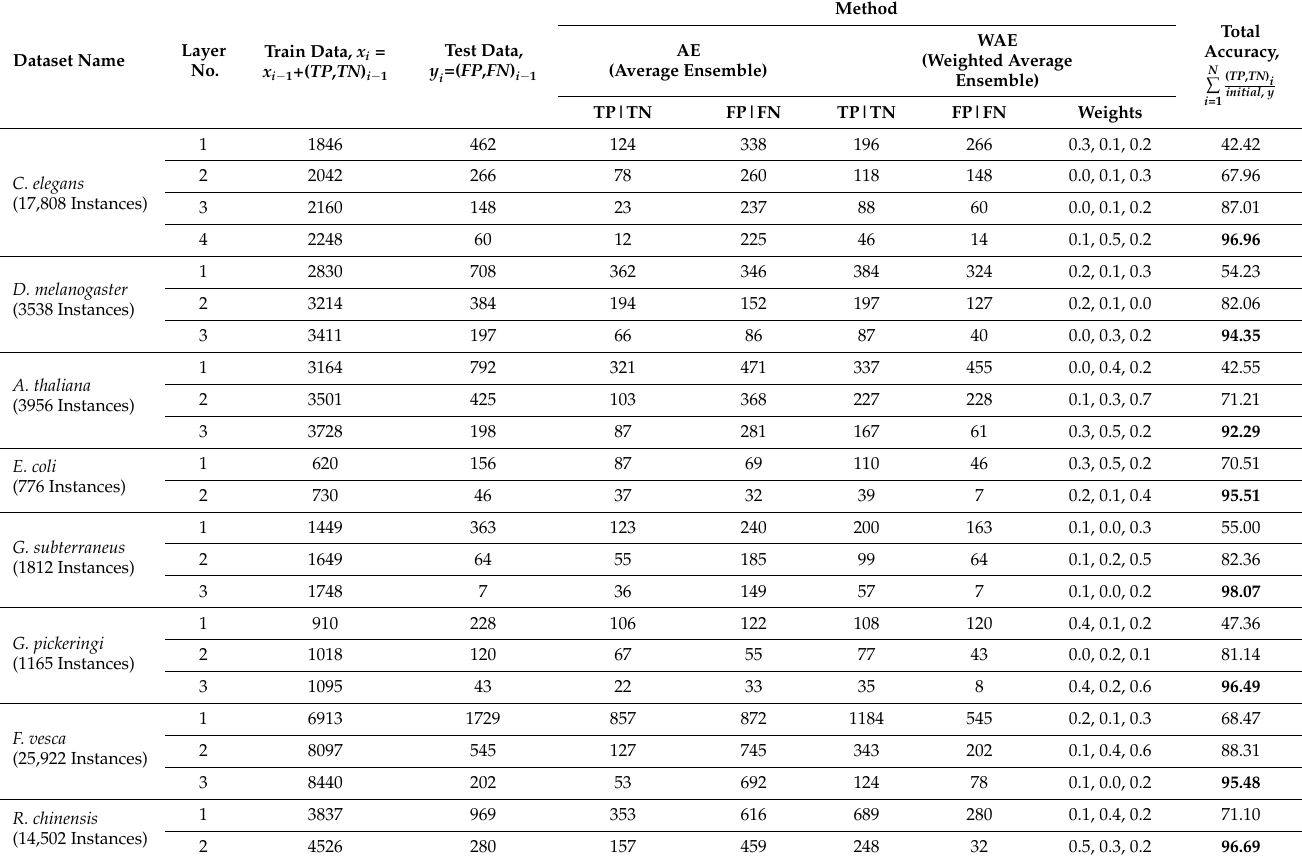
Table 7. Layer to layer classification performance of